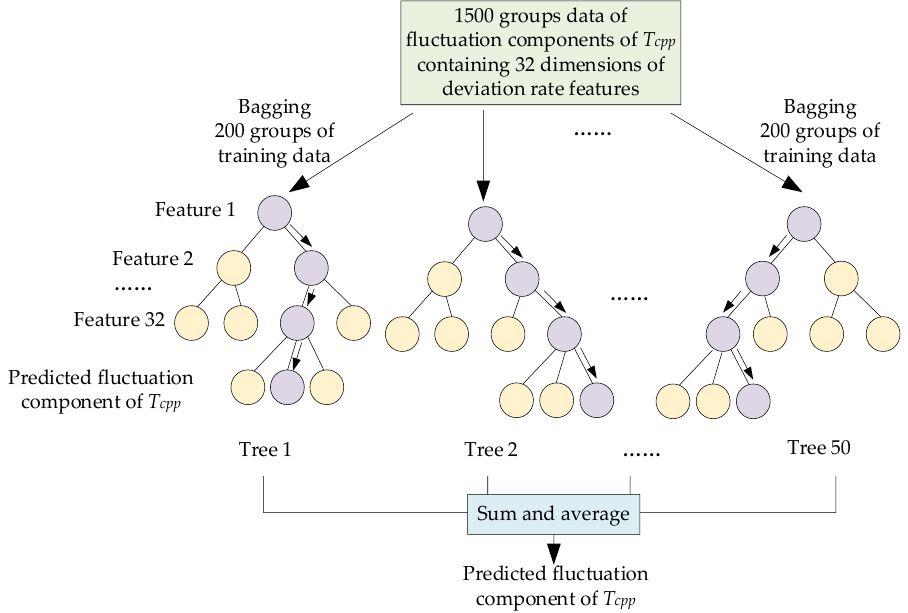
Figure 13. The approximate calculation process of the fluctuation component of T cpp . In order to verify the accuracy of the approximate model, 80 different groups of testing samples with tolerances were sampled outside the training data. The approximate modeling process and the calculation results of the compensate fluctuation (CF) method proposed in this paper are shown in Figure 14. The Kriging modeling method was used to establish the ideal component of T cpp , and the average RE between the approximate calculation and the parametric FEA is 11.7%, indicating that the ideal composition can be calculated with high accuracy by using the conventional approximate modeling method. The random forest method was adopted for the fluctuation components of T cpp , and the average RE between the approximate calculation and the parametric FEA is 53.1%. This was due to the lower magnitude of the fluctuation component, making the RE value higher. However, the fluctuation component of T cpp would be compensated for the ideal components, obtaining the approximate calculation of T cpp considering tolerances, the average RE of which is 7.7%. This showed that the compensation of the ideal component approximate modeling model improves the overall approximate modeling accuracy.